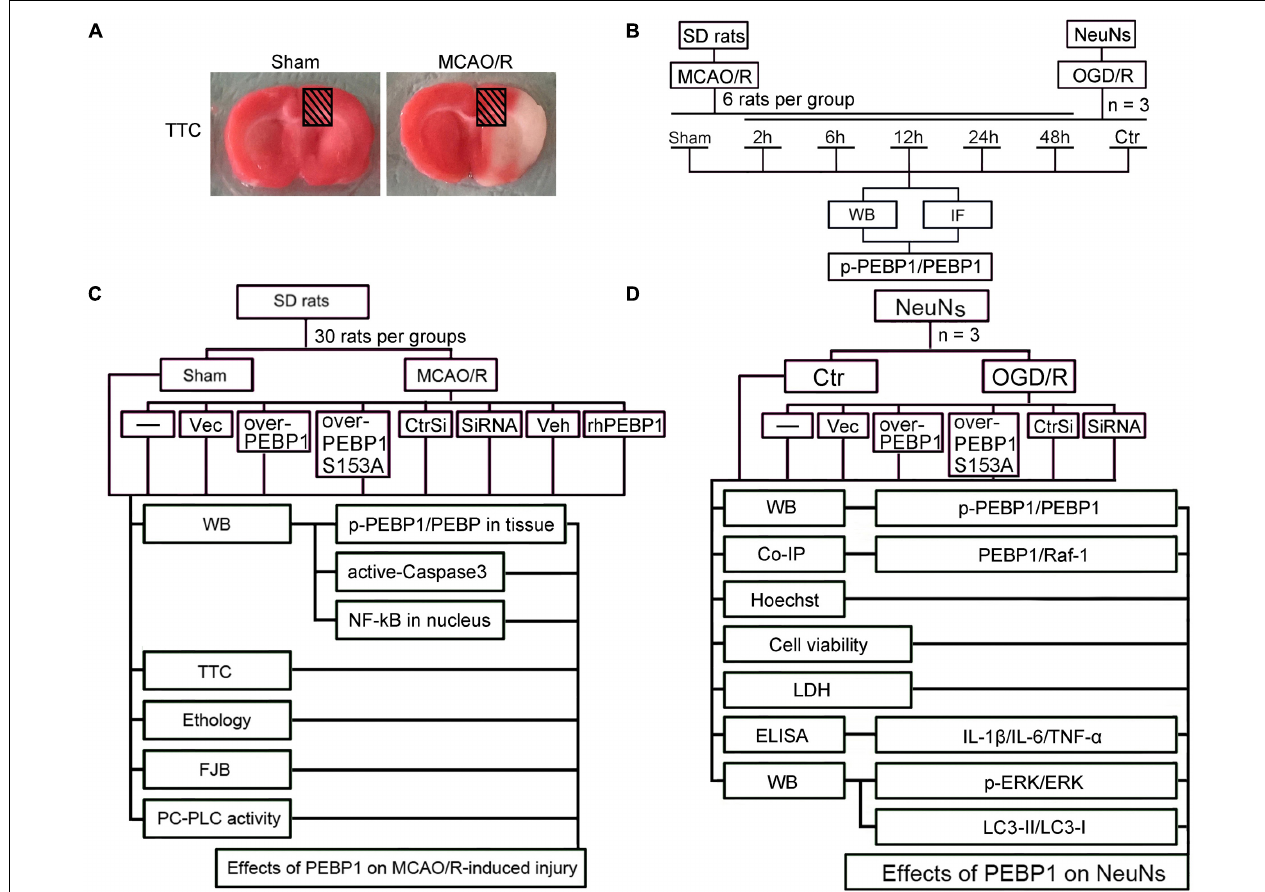
FIGURE 1 | Middle cerebral artery occlusion/reperfusion (MCAO/R) model and Experimental Design. (A) TTC staining of brain coronal sections at 2 h after MCAO/R surgery. (B) Time course analysis of the protein levels of PEBP1 and phosphorylated PEBP1 (p-PEBP1) after I/R. (C) Roles of PEBP1 in MCAO/R-induced injury. (D) Mechanisms underlying PEBP1 actions during I/R. p-PEBP1: phosphorylated PEBP1 at Ser153; PEBP1 (S153A): PEBP1 with Ser153 mutated to